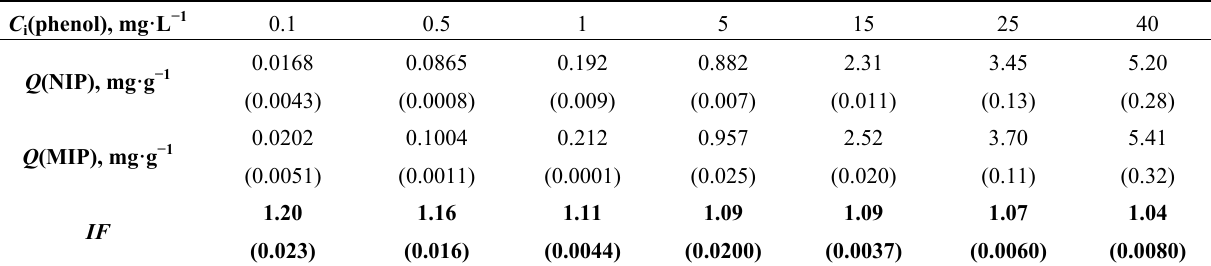
Table S2. Initial data for binding isotherms for MIP/NIP 5 (PETA) at low phenol concentrations (0.1-40 mg L − 1 ) for Figure5.